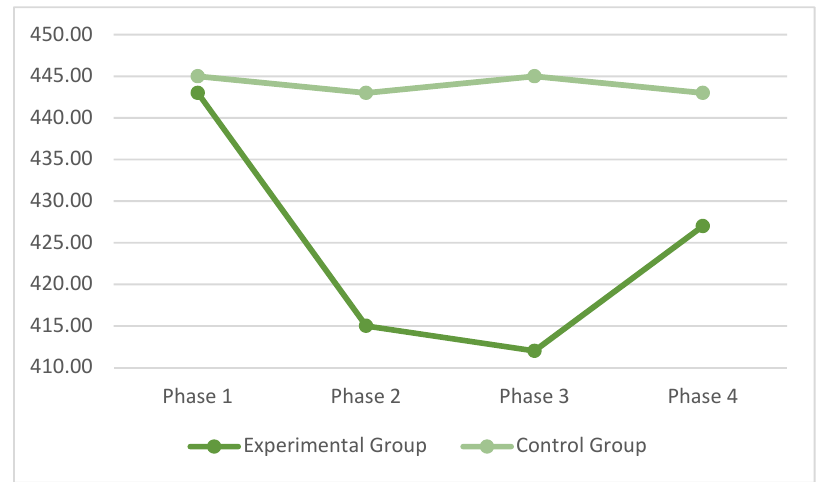
Figure 3. Means of the RT in the four phases of the Go/No Go Visual Research task.